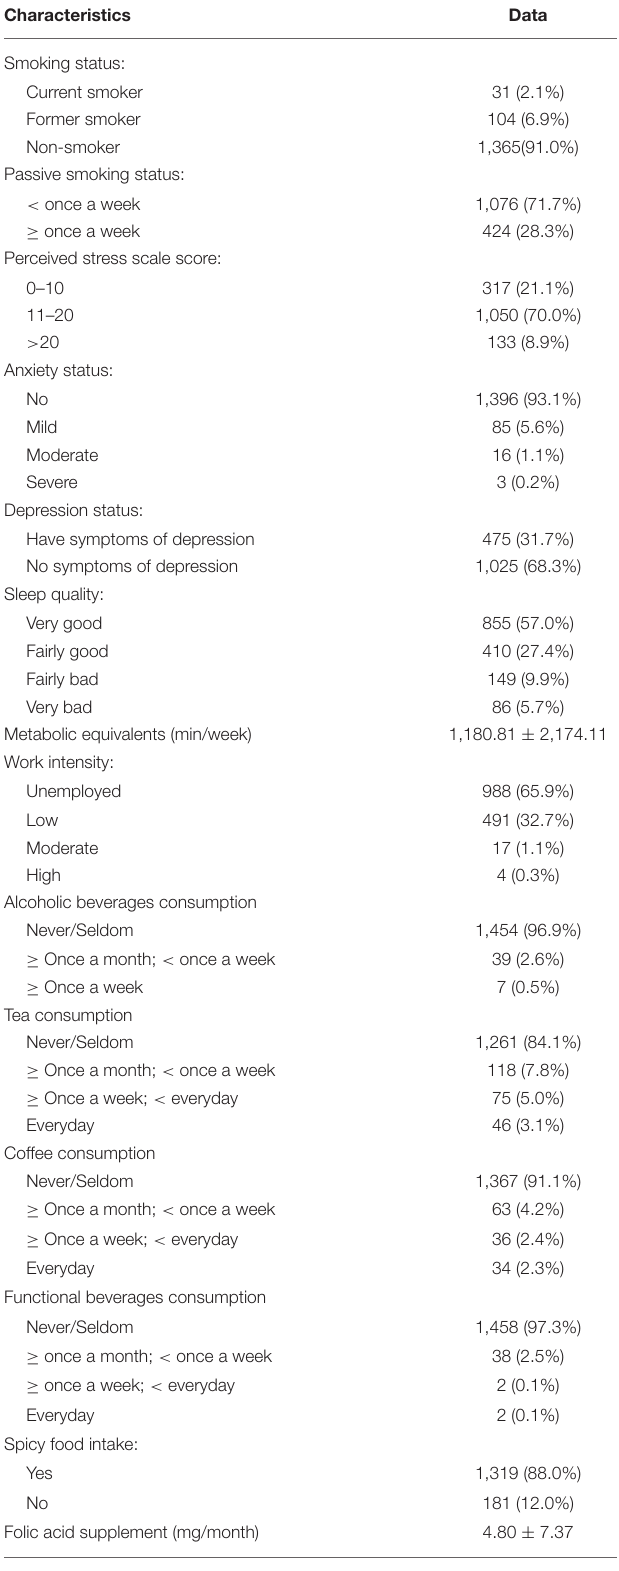
TABLE 2 | Lifestyle, psycho-mental status, beverage and spicy food consumption, and micronutrient supplement intake of the study population ( N = 1,500).